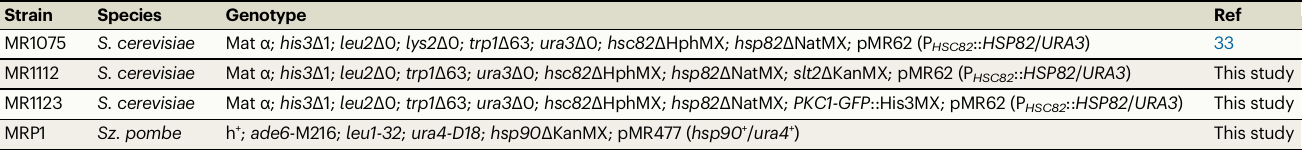
Table 1 | Strains used in this study